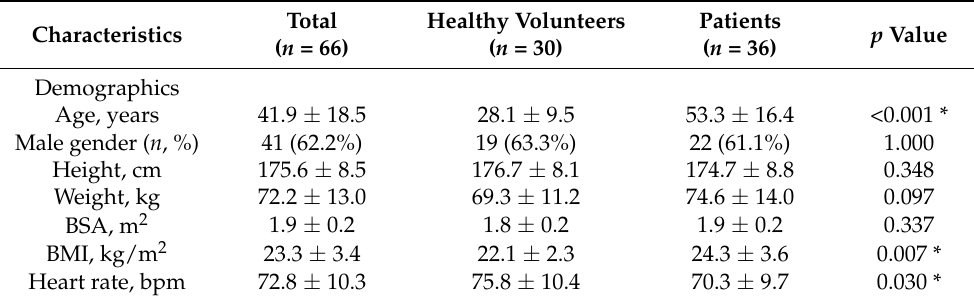
Table 1. Baseline clinical and demographic characteristics of the overall study population, with a comparison between healthy volunteers (group 1) and patients (group